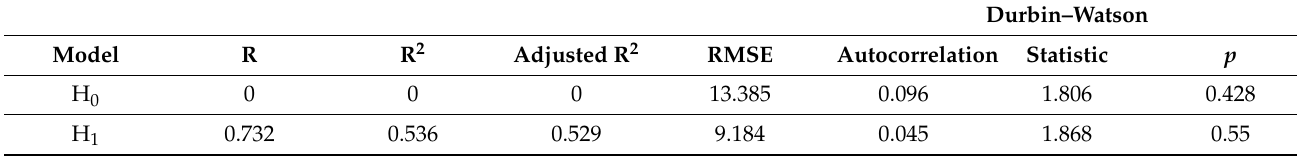
Table 5. Vertical dry plate method and wet candle method—model.